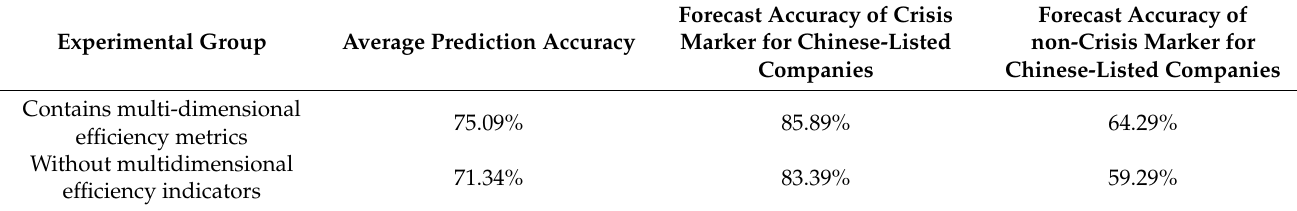
Table 11. The results of SVM prediction accuracy.